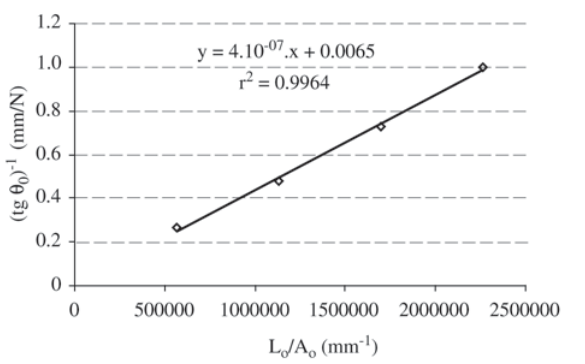
Figure 10. Graphical plot of Eq. 7 taken from experimental data from Table 5, for carbon fibres.